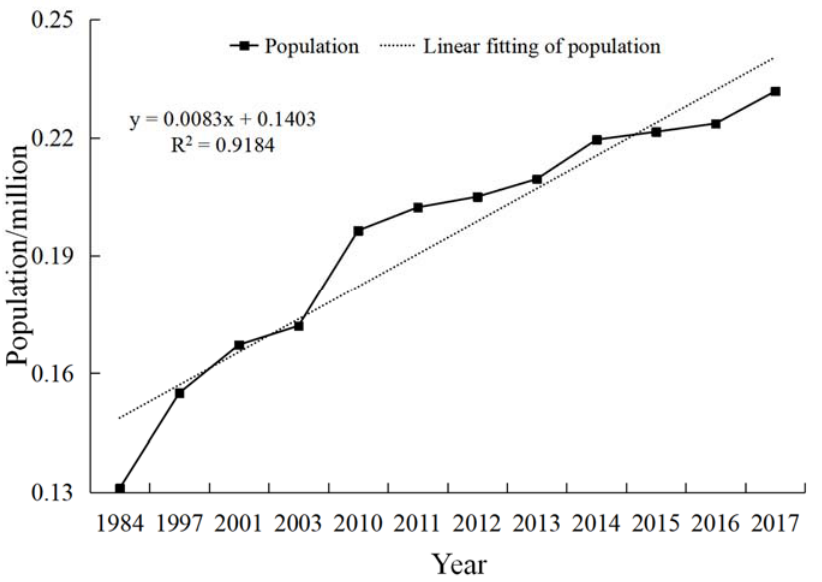
Figure 6. Population dynamic of Aketao county, China in 1984–2017. Note: The data was collected from statistics bureau of Aketao County.